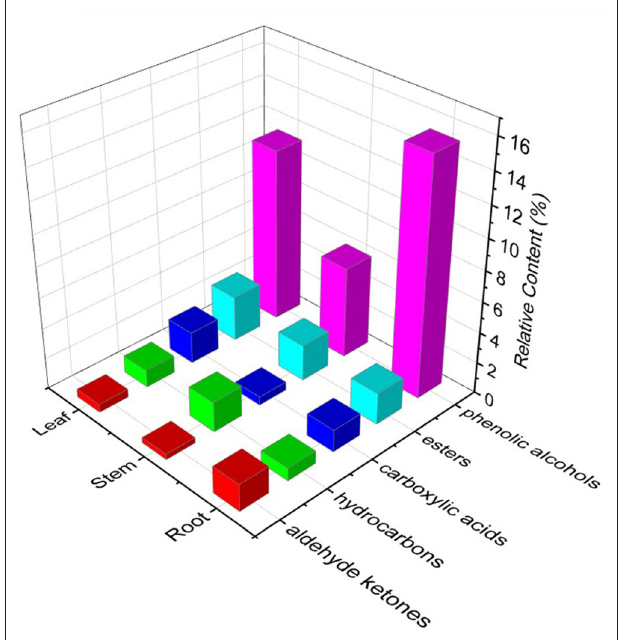
FIGURE 5 | Relative content of the volatiles in root, stem and leaf of P. notoginseng